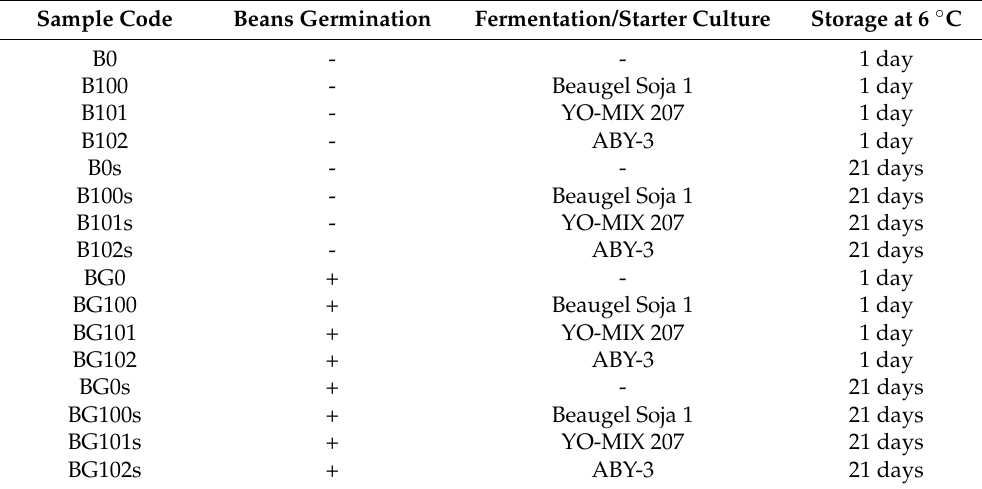
Table 1. The explanation of the sample codes for B and BG